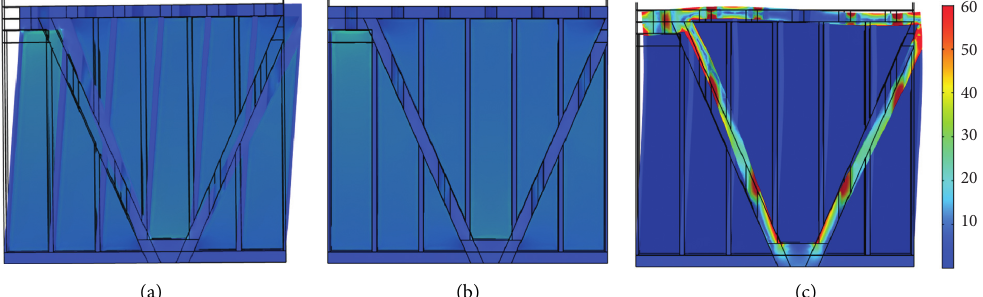
Figure 15: The steady-state stress distribution after being subjected to the same shear load. The deformation is enlarged 1 × 10 7 , 1 × 10 8 , and 1 × 10 8 times from (a) to (c), respectively.